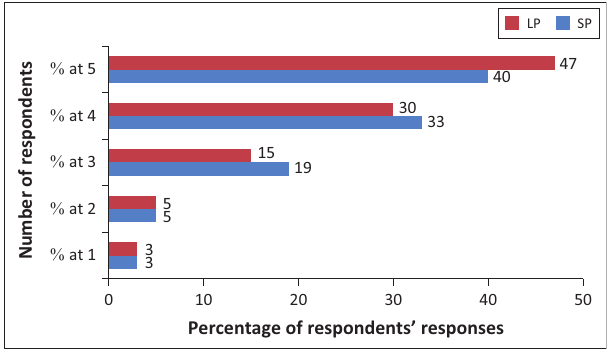
TABLE 9: Questions relating to entrepreneurial intention.